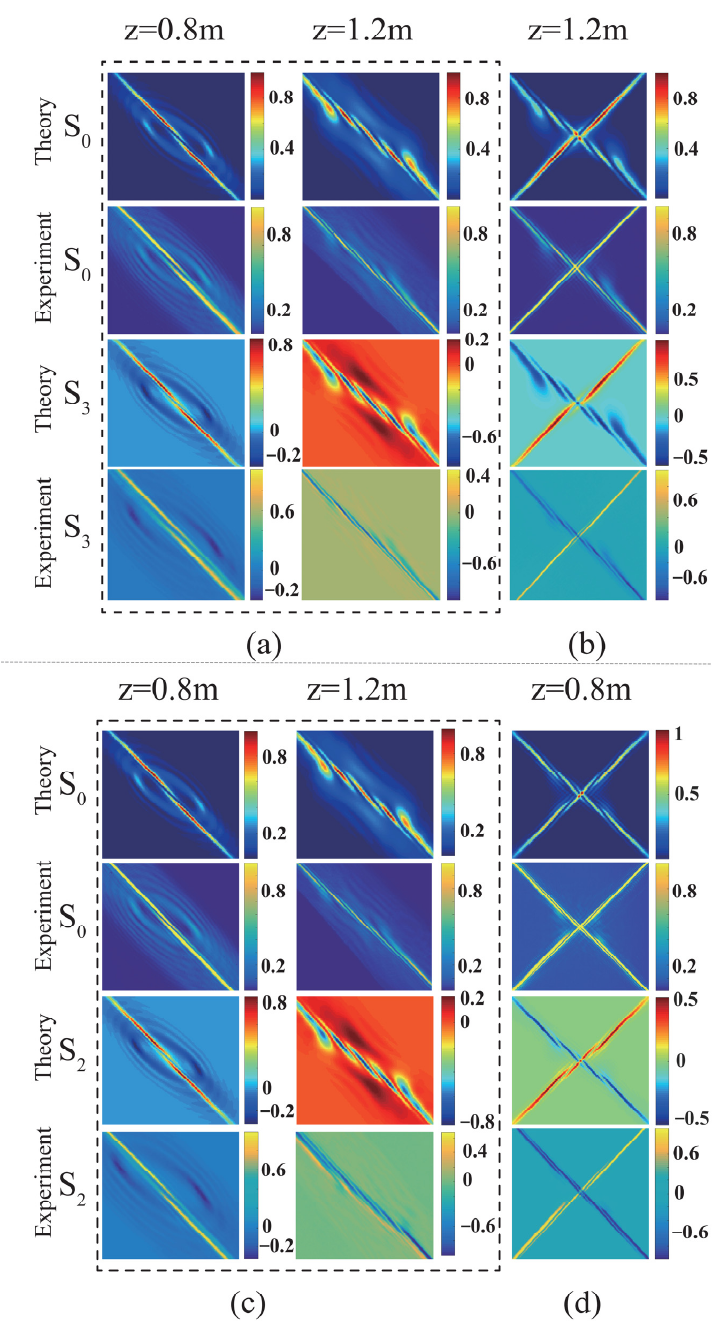
Figure 5. Simultaneous measurement of two vortex topological charges in a twisted vector beam by the interference fringes. All the plots are a zoom of the central parts of the interference fringes in Figures 3 and 4, as highlighted by the red dotted lines in Figure 3, and the actual size of any plot is 3269 λ × 3269 λ . ( a ) u 1 = 10 mm − 2 , u 2 = 15 mm − 2 , m 1 = 4, m 2 = − 1; ( b ) u 1 = 10 mm − 2 , u 2 = − 10 mm − 2 , m 1 = 4, The upper two rows are theoretical predictions, the lower two rows are experimental results. ( a ) and ( b ) are for locally linear polarizations ( Δ θ = π /2), and ( c , d ) are for hybrid polarizations ( Δ θ = 0).